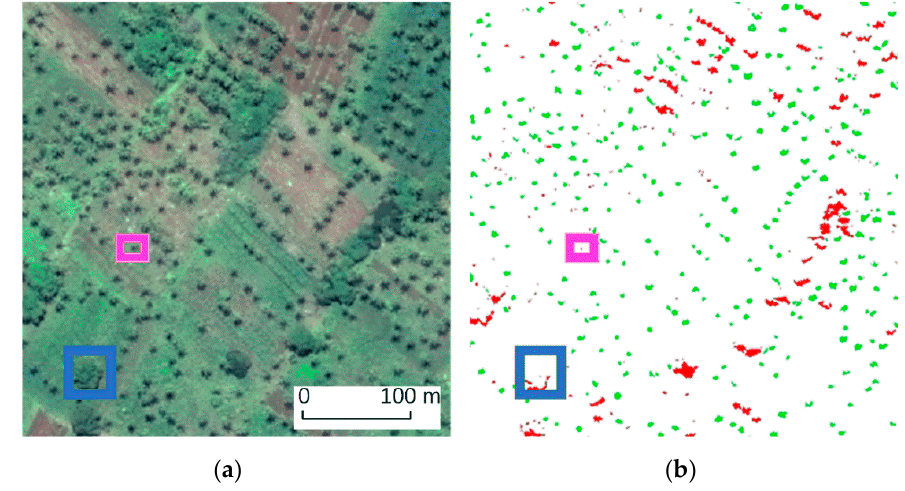
Figure 3. Input WorldView-3 image in true-color composite is shown in ( a ). Coconut tree detection shows the cluster of selected sizes in green ( b ). You may notice the bigger trees are not selected (blue square) as well as the smaller shadows (magenta square).